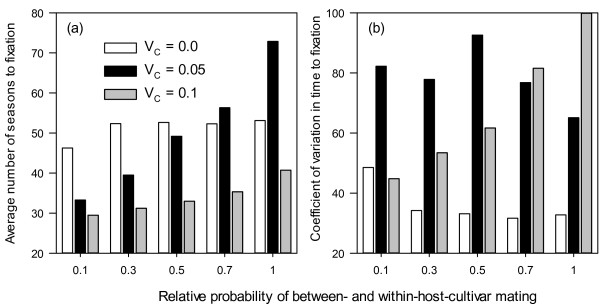
Average time (number of seasons) to fixation (a) and its coefficient of variation (b) in relation to cost of virulence and the probability of mating between diseased units from different cultivars.